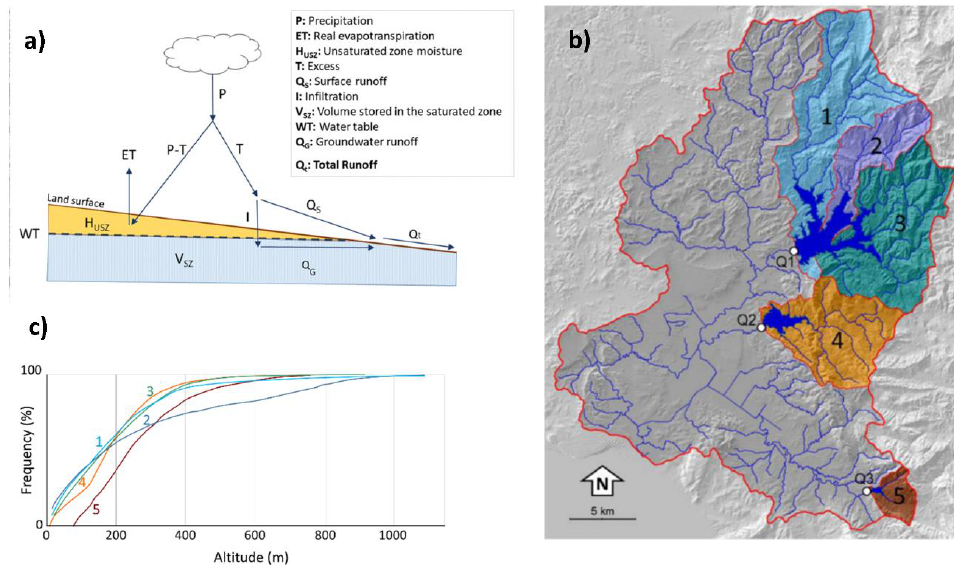
Figure 4. ( a ) The T-RRM conceptual scheme. ( b ) Barbate River Basin. Sub-basin scheme associated with the availability of gauging data (Qi): Barbate reservoir (Q1, sub-basins 1, 2, and 3); Celemín reservoir (Q2, sub-basin 4); Almodóvar reservoir (Q3, sub-basin 5). ( c ) Hypsometric curves of the 5